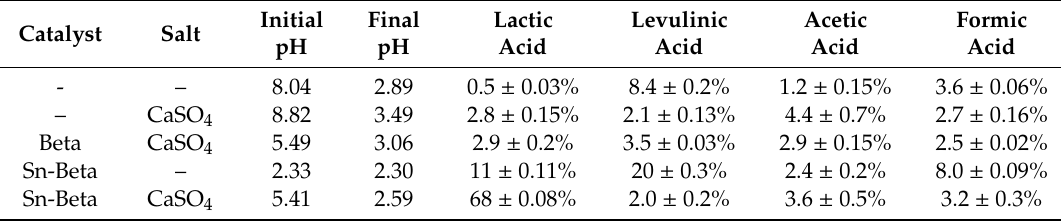
Table 3. Organic acid yields from CaSO 4 catalyzed reaction of glucose (200 ◦ C reaction temperature,